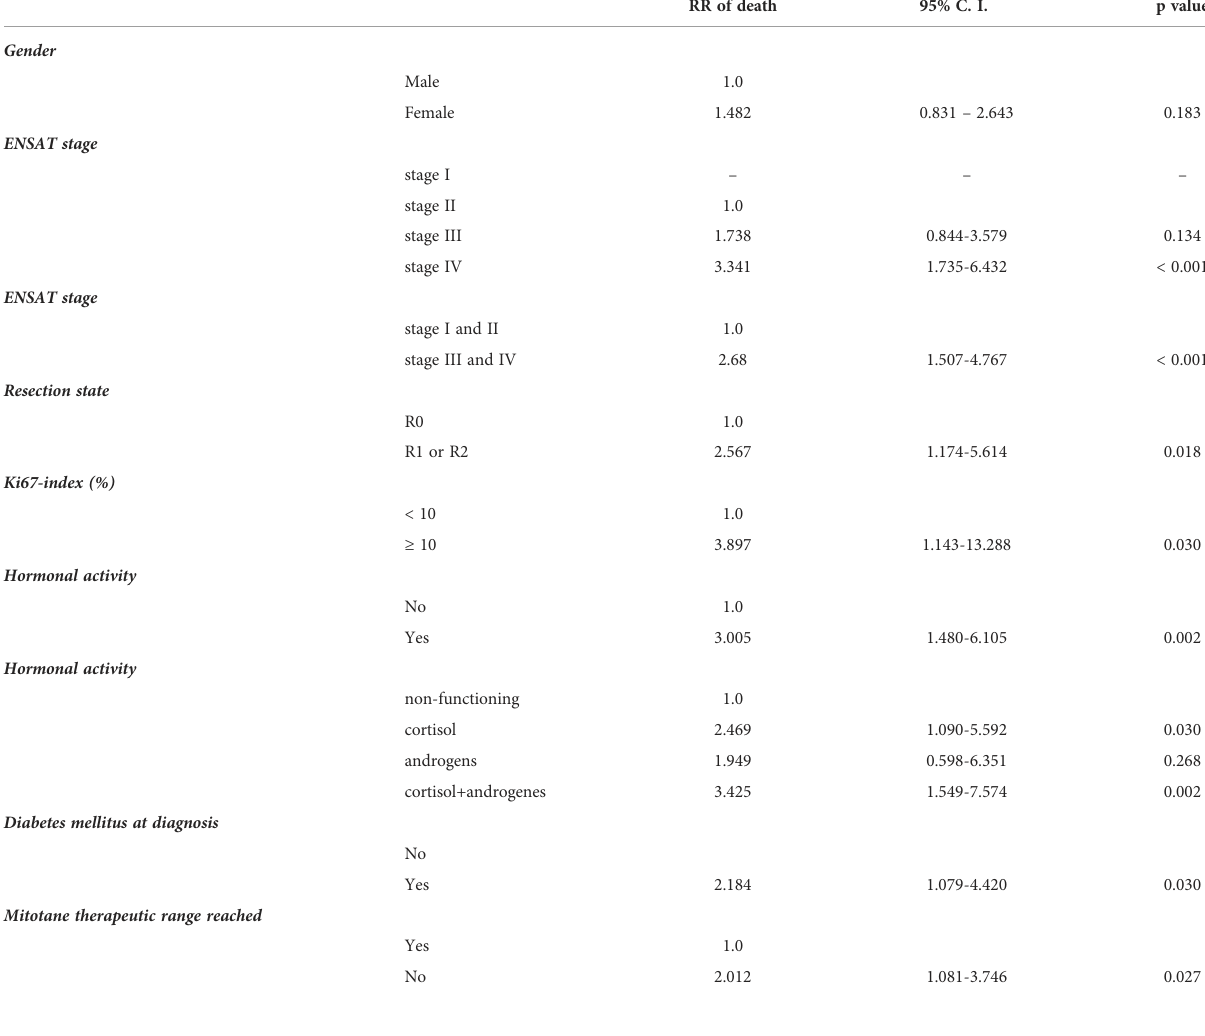
TABLE 2 Factors associated with mortality of patients with adrenocortical cancer using univariate Cox proportional hazard model. RR of death 95% C. I.